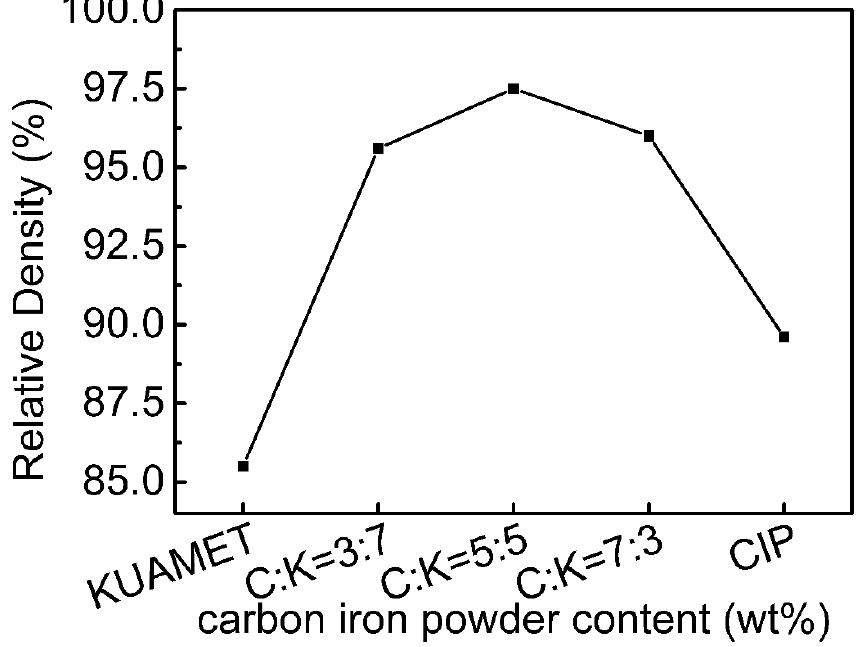
Figure 5. Variation of the compaction densities of the compacted bodies after heat treatment with different powder mixing ratios.